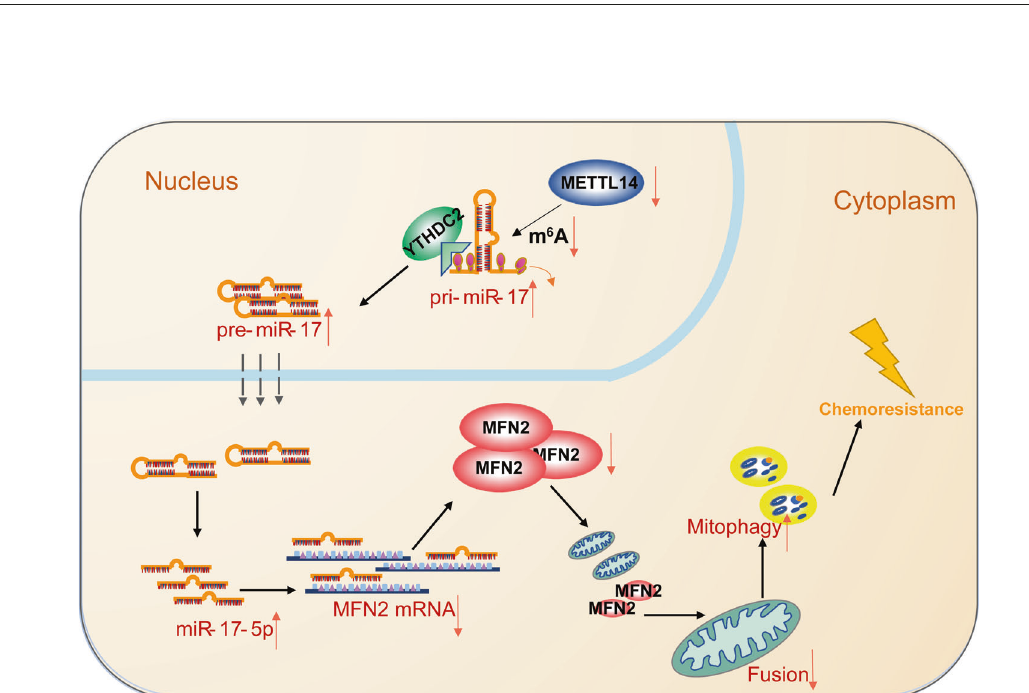
Fig. 6 METTL14 depletion signi fi cantly enhances 5-FU resistance via the miR-17-5p/MFN2 axis. A Correlation between METTL14 and miR- 17-5p expression levels in CRC tissues with linear regression lines ( n = 30). B RT-PCR analysis of METTL14, miR-17-5p and MFN2 expression levels in normal intestinal epithelial cells and CRC cell lines. C, D Rescue experiments on METTL14 and miR-17-5p: IC50 and Annexin V-PE/ 7AAD apoptosis of 5-FU in HCT116 cells. In ( D ), P (si- METTL14 + i-NC vs. si-NC + i-NC) = 0.0010; P (si- METTL14 + i-NC vs. si- METTL14 + i-miR-17- 5p) = 0.0005. P (mic-NC + NC vs. mic-miR-17-5p + NC) = 0.0096; P (mic-miR-17-5p + NC vs. mic-miR-17-5p + METTL14 OE) = 0.0005. E Western blot analysis of LC3B, p62, BAX, BCL2, Caspase7, cleaved Caspase7, MFN2, FIS1, METTL14 of rescue experiments. F Transfection ef fi ciency of cell lines with stable co-expression of miR-17-5p and a control vector (NC/miR-17-5p, P = 0.0007) or METTL14 (METTL14 OE/miR-17-5p, P = 0.0190). G Nude mice were implanted with tumor cells subcutaneously. H , I Tumor sizes and weights of xenograft in three groups after 6 times 5-FU treatment. In ( I ), P (NC/NC vs. NC/miR-17-5p) = 0.0030, P (NC/miR-17-5p vs. METTL14 OE/miR-17-5p) = 0.0111. J The changes of tumors volume during the treatment of 5-FU. K Immunohistochemistry analysis of Caspase7 and MFN2 in three groups. P Caspase7 (NC/NC vs. NC/miR-17-5p) = 0.0049; P Caspase7 (NC/miR-17-5p vs. miR-17-5p/METTL14 OE) = 0.0003; P MFN2 (NC/NC vs. NC/miR-17-5p) ˂ 0.0001; P MFN2 (NC/miR-17-5p vs. miR-17-5p/METTL14 OE) = 0.0002. Results shown were representative of at least 3 independent experiments. Statistical signi fi cance in ( A ) was assessed by Pearson correlation analysis. Statistical signi fi cance in ( C ), ( D ), ( F ), ( I ), ( J - K ) was determined by one-way ANOVA with Dunnett ’ s multiple comparisons test. *, P <0.05; **, P <0.01; ***, P <0.001. Error bars, SD. Scale bars, 100 μ m in ( K ). The IHC score and grey value of protein bands have been quanti fi ed by Image J, and the grey value of LC3B shown the ratio of LC3II/LC3I.